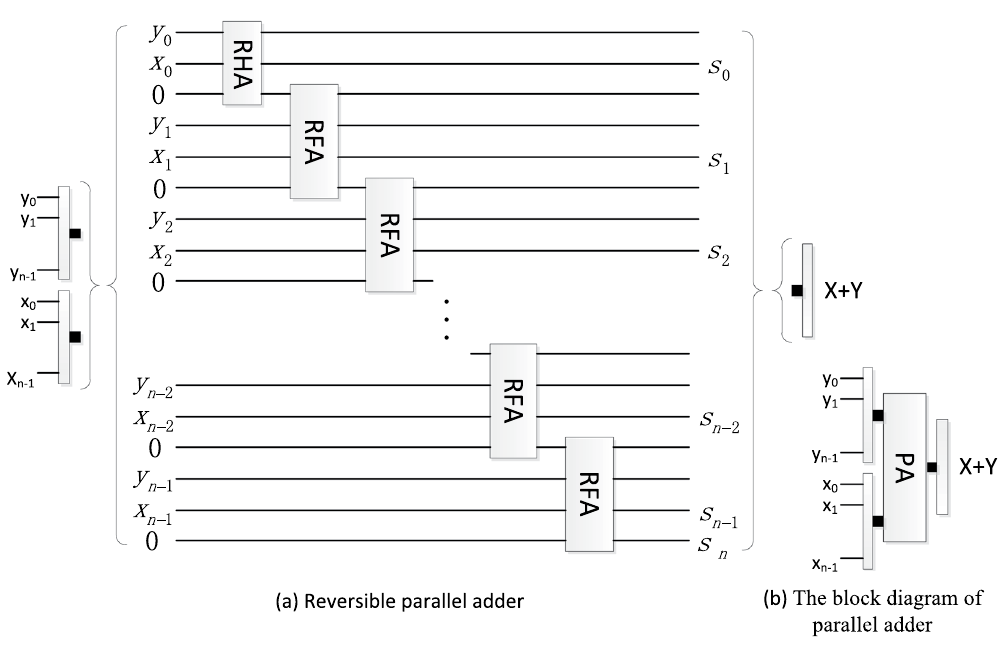
Figure 14. The reversible parallel adder and its block